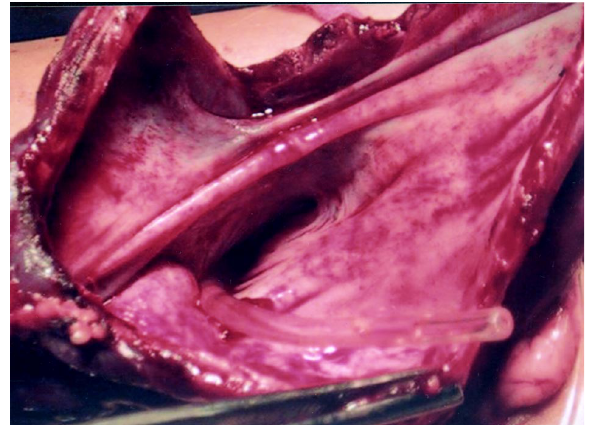
Figure 3 – Surgical specimen. Note the renal upper pole and corresponding